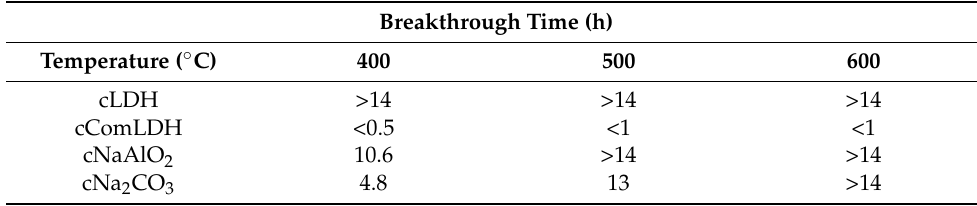
Table 2. Summary of the 1 ppm HCl breakthrough times of sorbents.